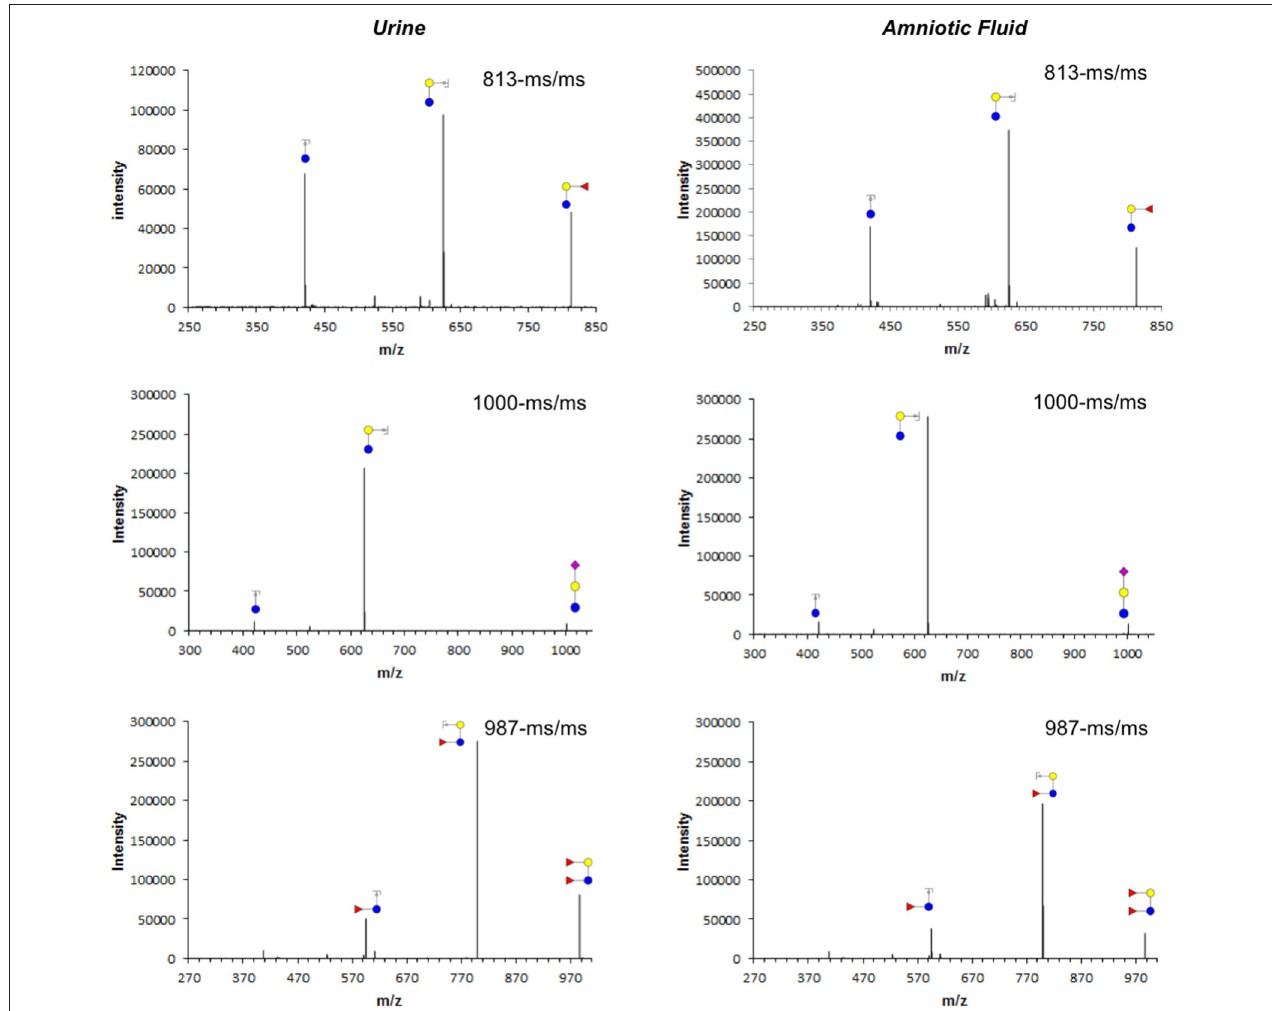
FIGURE 2 | Tandem mass fragmentation of selected ions from 2-AB labeled per-O-methylated oligosaccharides isolated from maternal urine (left) and amniotic fluid (right). Cartoon structures of Y-type fragments are shown for parent mass 813 (2 ′ -fucosyllactose, top), 1,000 (3 ′ -sialyllactose, middle), and 987 (difucosyllactose, bottom) with glucose (blue circle), galactose (yellow circle), fucose (red triangle), and sialic acid (purple diamond) as monosaccharide building